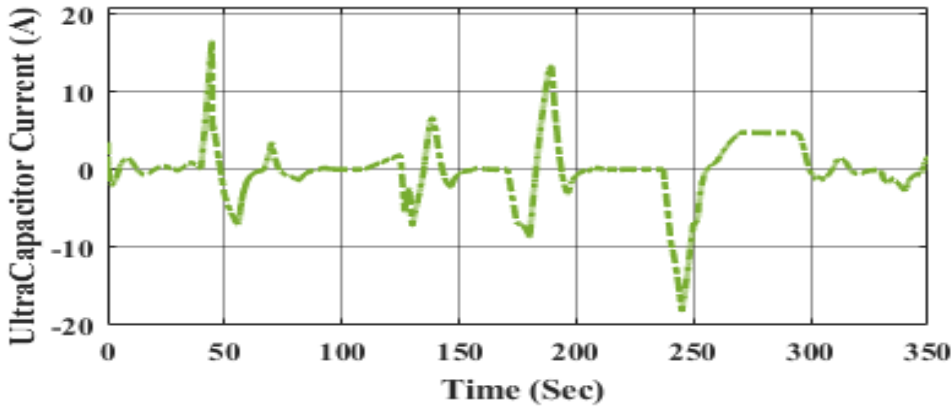
Figure 23. Time response of ultracapacitor voltage.